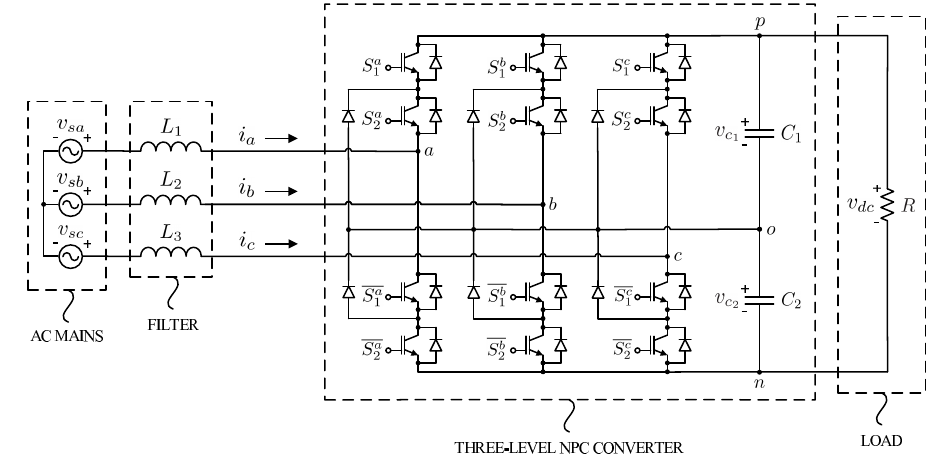
Figure 1. Schematic diagram of the three-phase three-level neutral-point-clamped (NPC) rectifier. The electrical power grid is considered as a three-phase voltage source, where the phase voltages are represented by v sa , v sb and v sc . The converter is connected to the grid through an inductive filter where inductances have the same value L